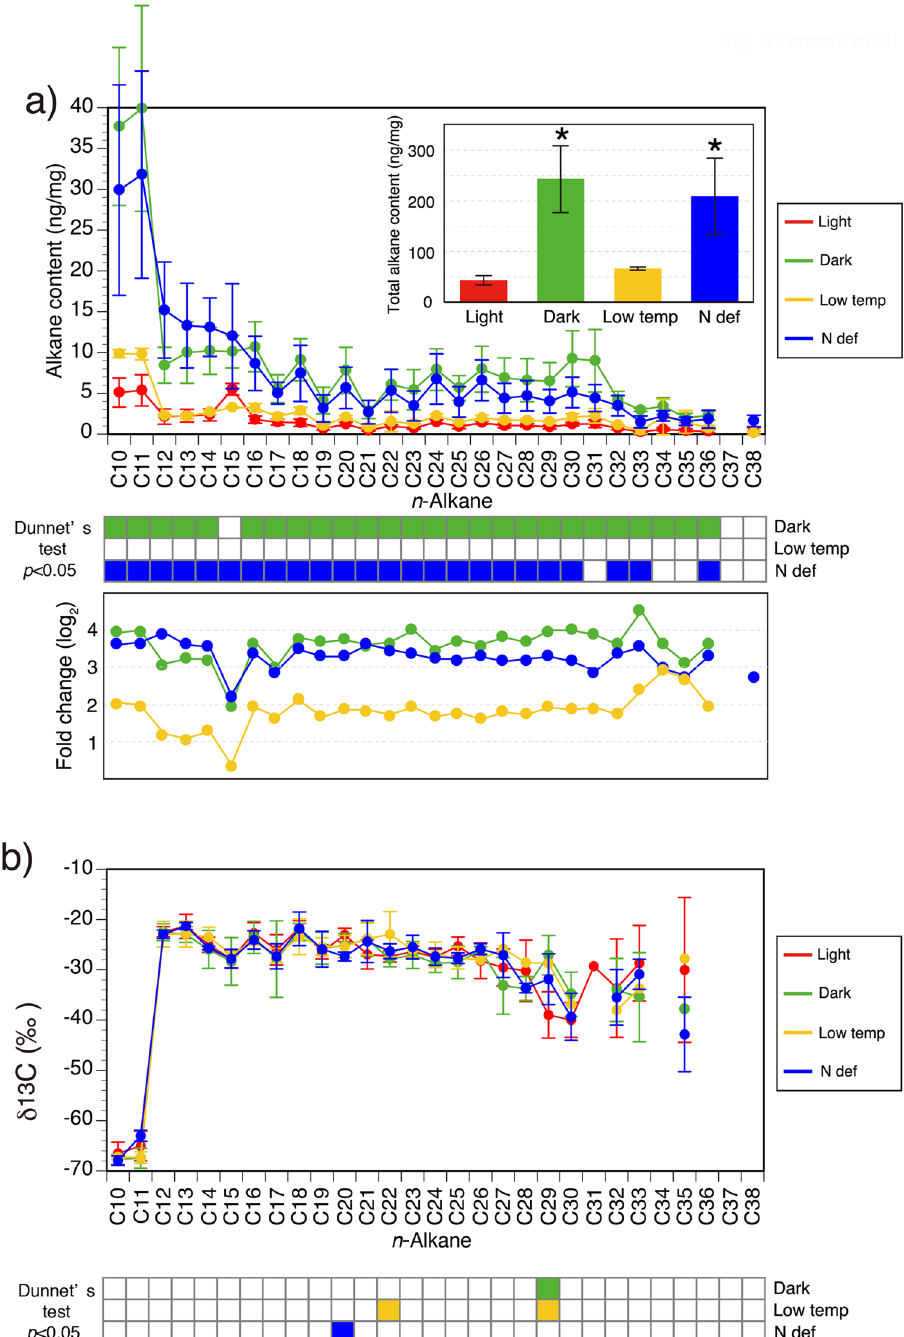
Figure 5. Effect of environmental conditions on the concentrations and compound-specific δ 13 C of n -alkanes in the ARC1 strain. ( a ) Concentration of a series of n -alkanes per dry weight; ( b) n -alkane compound-specific δ 13 C composition. Both were quantified in the ARC1 strain grown under four different culture conditions: continuous light at 20 °C (light); continuous dark at 20 °C (dark); continuous light at 4 °C (low temp); and continuous light under nitrogen-deficient conditions at 20 °C (N def). Error bars indicate standard deviations ( n = 3 for dark, low temp, and N def conditions; n = 6 for light condition). Significant differences in the total amount of the series of n -alkane concentrations between light and low temp, dark, or N def conditions were detected by Dunnett’s test (asterisks show p < 0.05 in the inset figure). For each alkane compound, environmental conditions showing the significant difference in the Dunnett’s test ( p < 0.05) are shown as filled boxes. Lines, bars, and boxes are colored to reflect growth